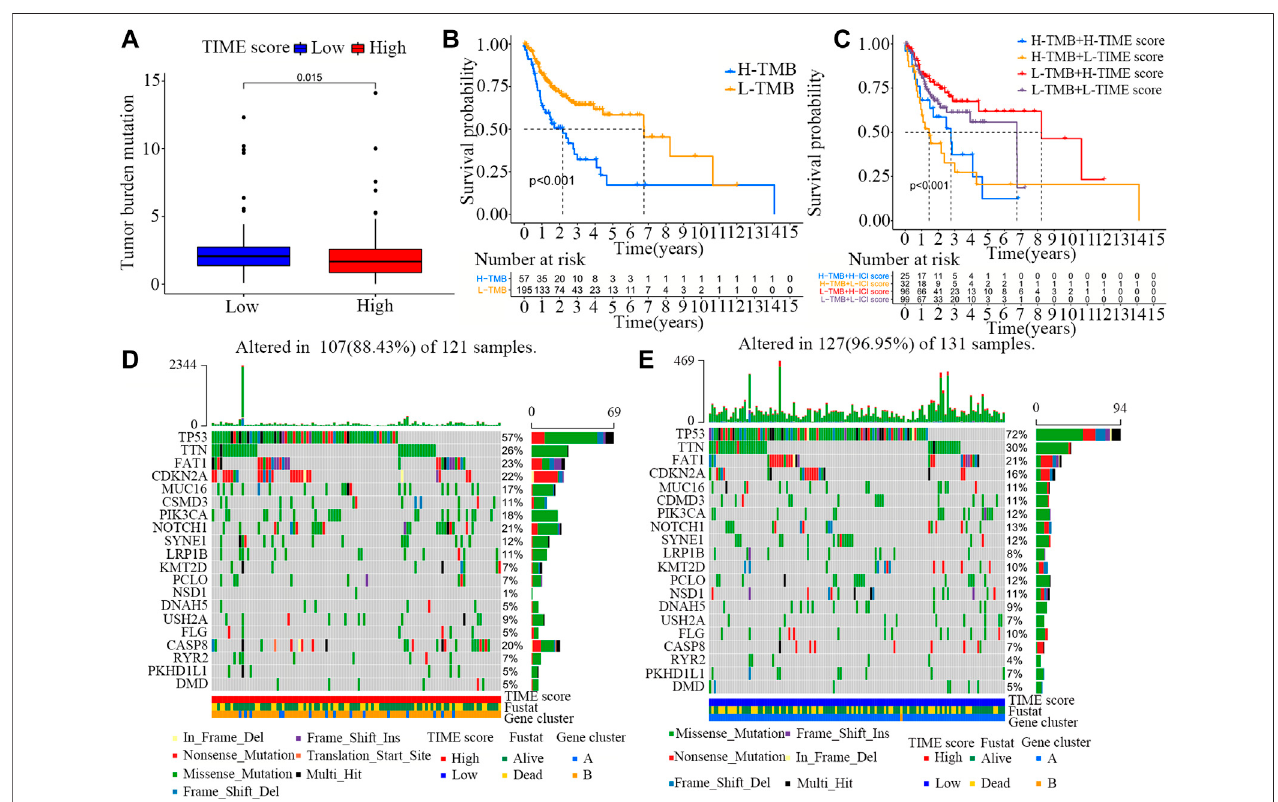
FIGURE 4 | Association between TIME scores and somatic mutations. (A) Difference in TMB scores between high and low TIME score groups. Wilcoxon test, p = 0.015. (B) Survival rates of OSCC patients in high and low TMB score groups. Log-rank test, p < 0.001. (C) Survival rates of OSCC patients strati fi ed by TIME and TMB scores. Log-rank test, p < 0.001. (D) Construction of the oncoPrint based on high TIME scores on the left (red). (E) Construction of the oncoPrint based on low TIME scores on the right